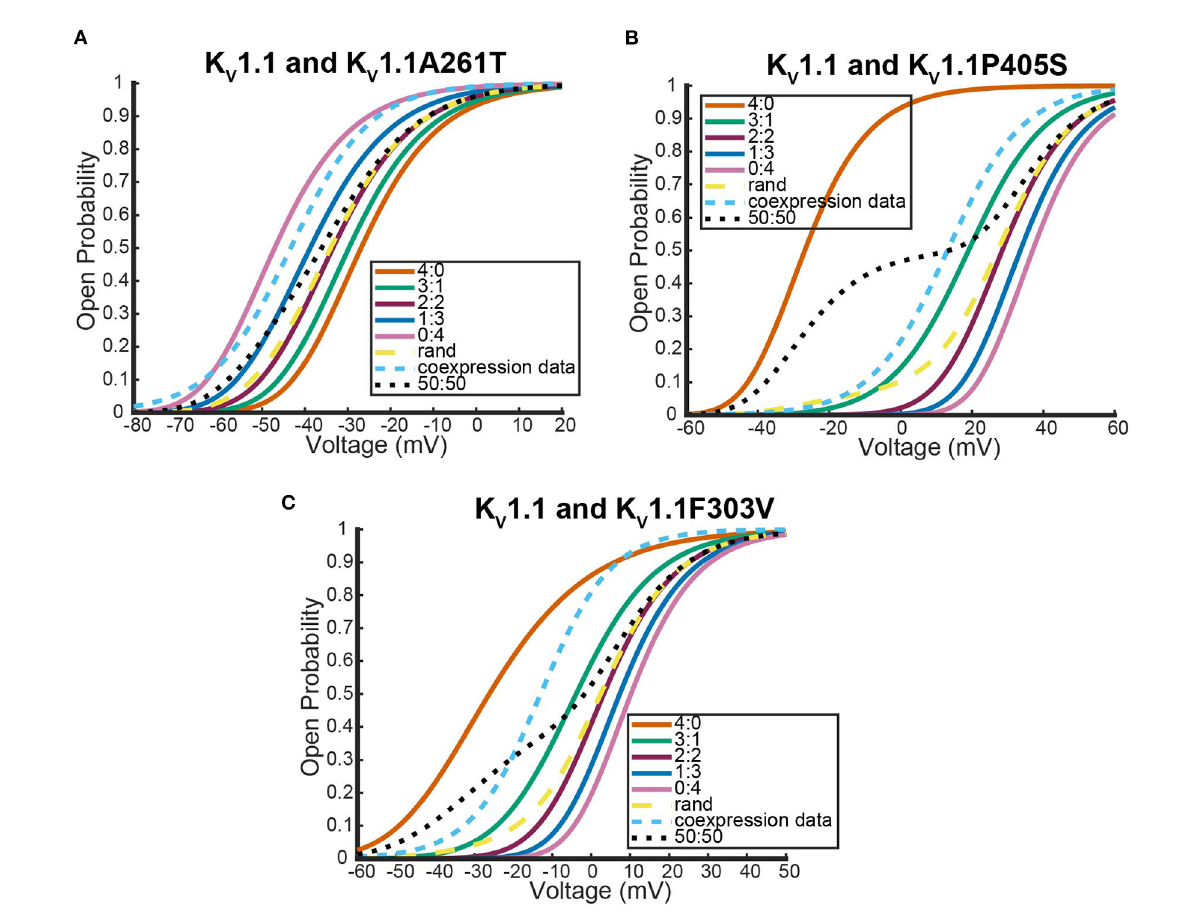
FIGURE7 Steady state probability curves as a function of voltage for cells containing various channel types in three different experiments. The coexpression data and homomeric data for model fitting was taken from Miceli et al. (2022) (A,B) and Hasan et al. (2017) (C) . The steady state probability curves presented here are for homomeric K v 1.1 (4:0) and K v 1.1 mutant (0:4) channels, heteromeric assembly of K v 1.1 and K v 1.1 mutant subunits (3:1, 2:2, 1:3), the model output of a random assembly of K v 1.1 and K v 1.1 mutant subunits expressed in 50:50 ratio (rand), the data output of a 50:50 expression of K v 1.1 and mutant K v 1.1 subunits (coexpression data), and a model output of an equal split between only homomeric channels (50:50). Curve color and type are shown in the legends. Homomeric channels and their related heteromers being looked at are also detailed in figure